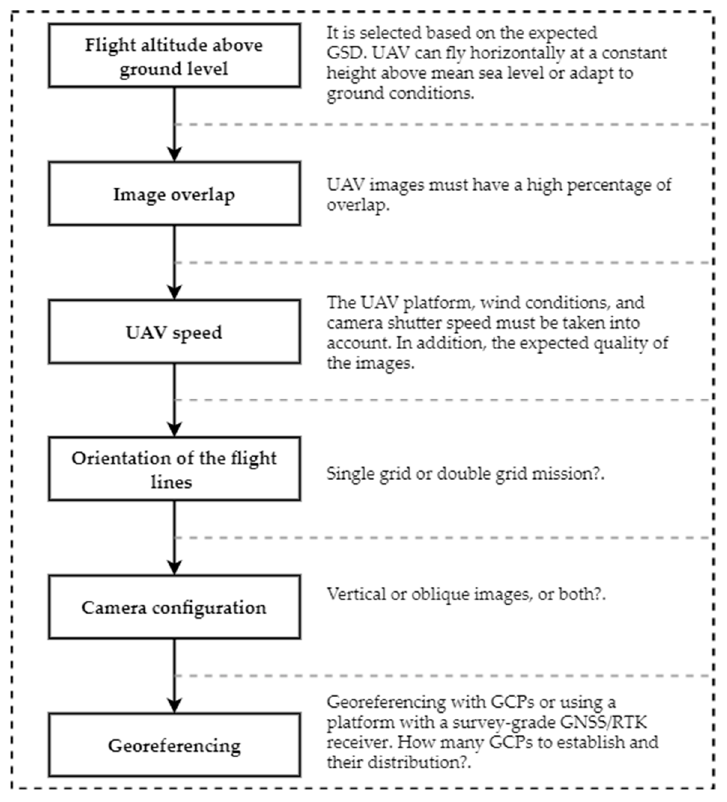
Figure 1. Flight planning parameters.